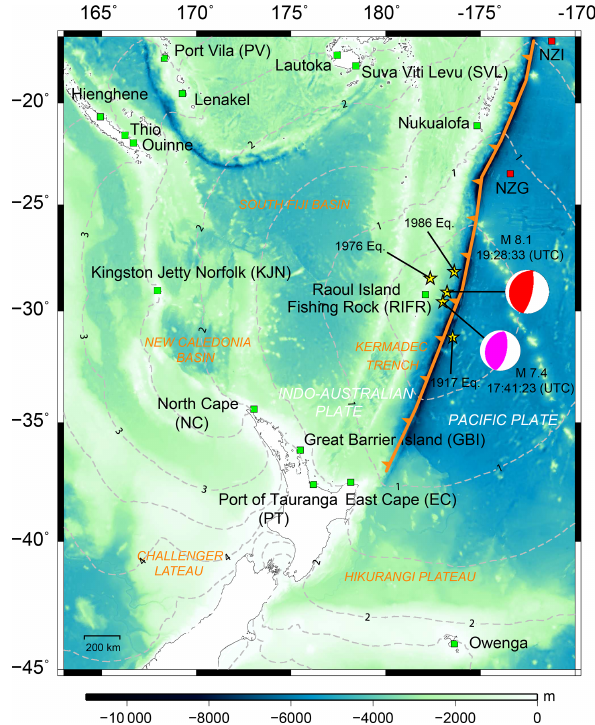
Figure 1. Bathymetry map of the southwestern Pacific region and the epicenters of two successive earthquakes in the Kermadec Is- lands on 4 March 2021. Pink and red beach balls represent the fo- cal mechanisms (according to the Global Centroid Moment Ten- sor Project; https://www.globalcmt.org/CMTsearch.html, last ac- cess: 18 June 2021) of the M w 7.4 and M w 8.1 earthquakes, re- spectively. Green squares indicate tide gauges. Red squares indi- cate Deep-ocean Assessment and Reporting of Tsunamis (DARTs) tsunameters. The travel time of the second tsunami is marked by gray dashed contours with an interval of